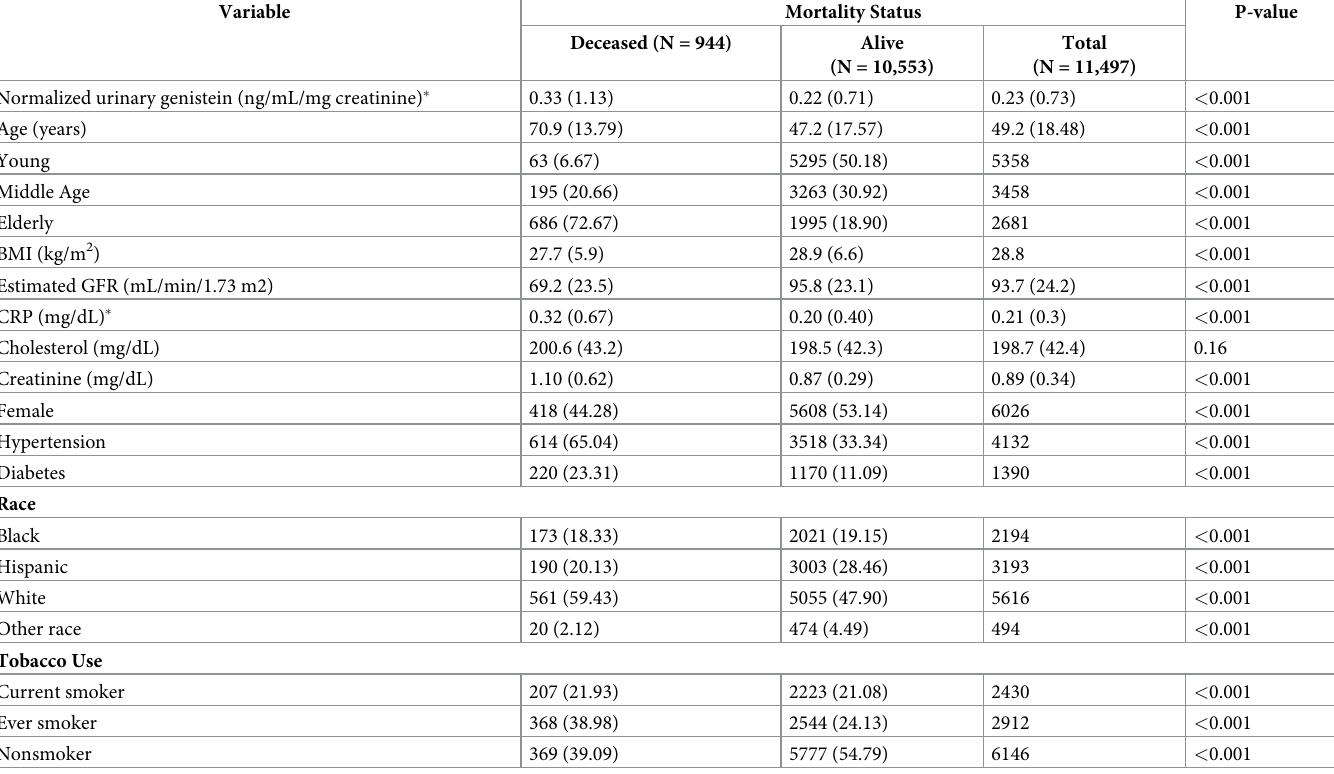
Table 1. Population variables by mortality